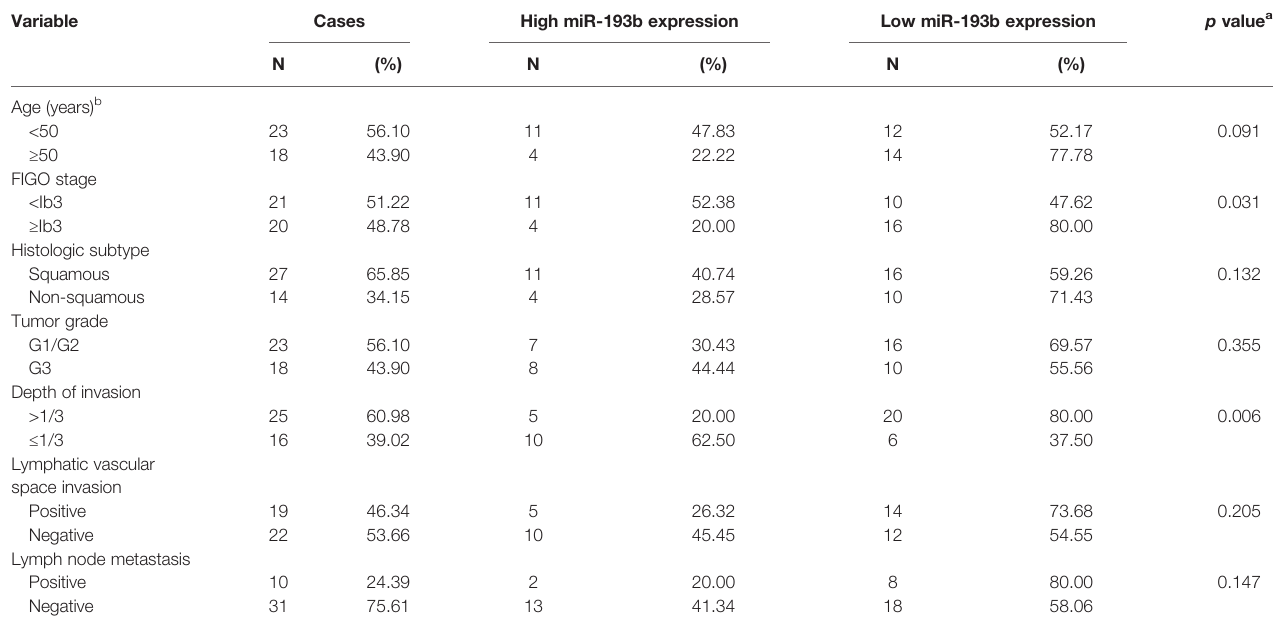
TABLE 1 | Clinical Signi fi cance of miR-193b in cervical cancer. Variable